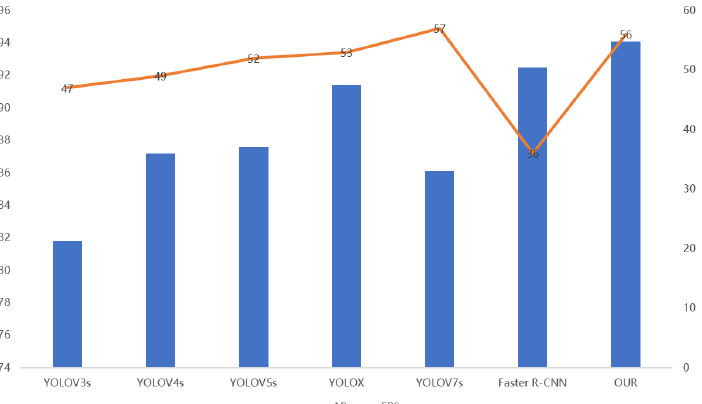
Figure 12. In the comparison of mAP and FPS values of different detectors, the horizontal axis represents different detectors, the vertical axis in the left half represents mAP values, and the vertical axis in the right half represents FPS